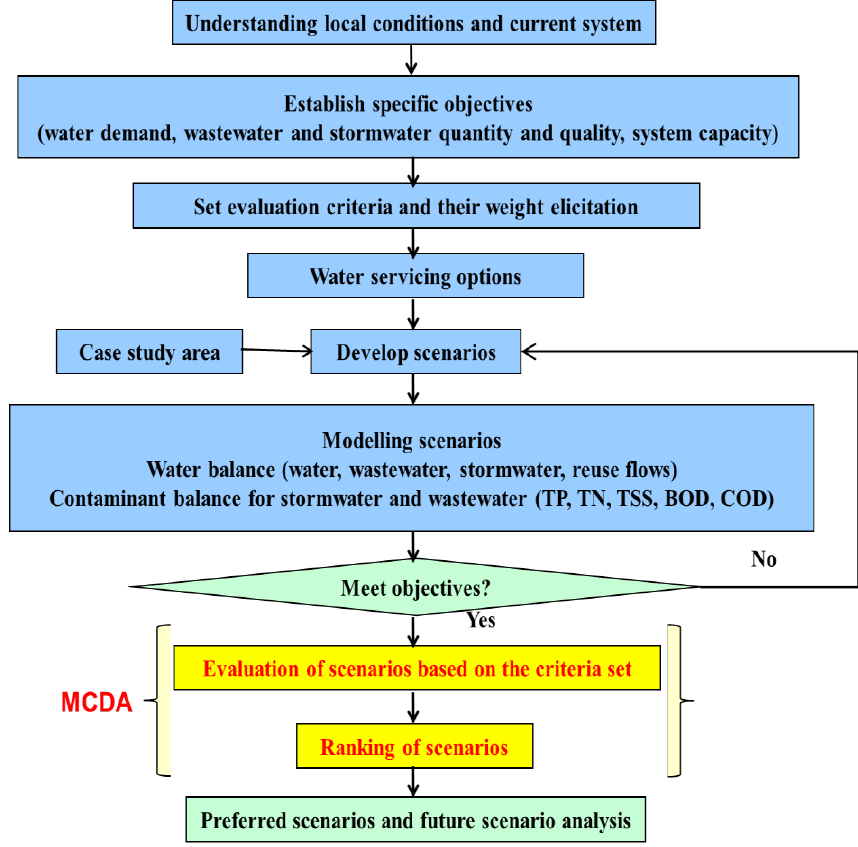
Figure 1. Hybrid water supply system evaluation framework [9].